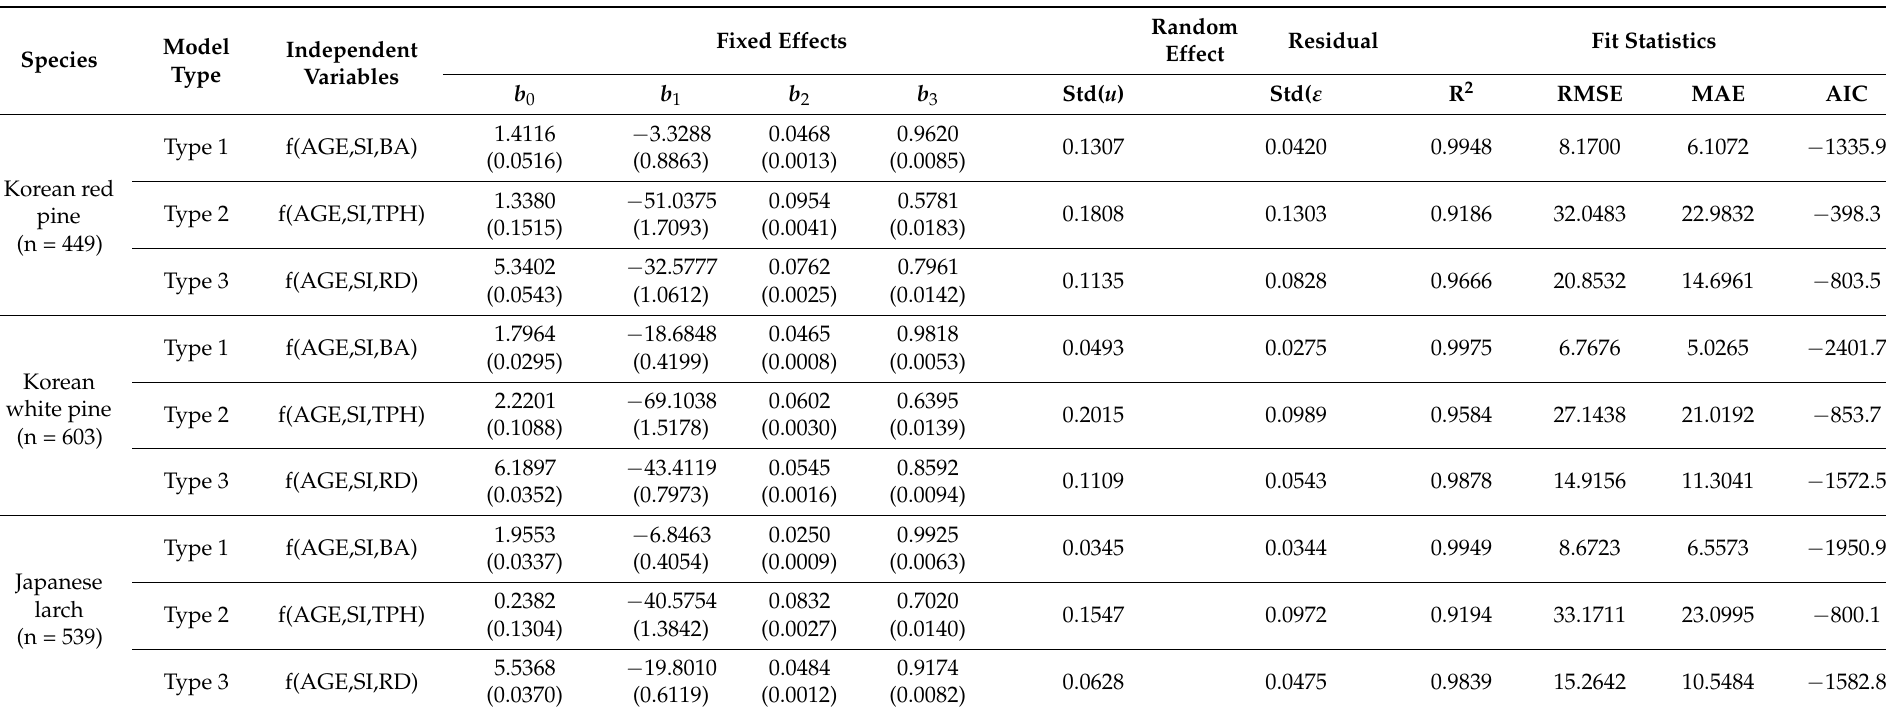
Table 4. Parameter estimates and fit statistics for the variable-density yield models to predict the stand volume at the whole stand level by